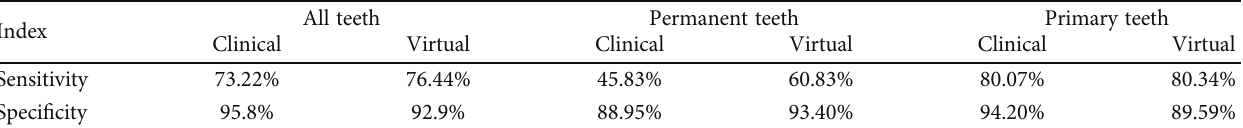
Table 4: Sensitivity and speci fi city for detection of sound and carious teeth in virtual and clinical